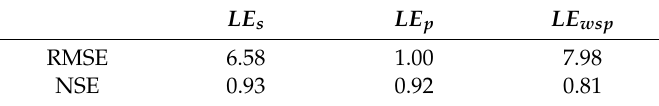
Figure 3. The linear relationship between the predicted and measured values of latent fluxes under WSPI: ( a ) LE s ; ( b ) LE p ; ( c ) LE wsp . Table 3. Results of root mean square error (RMSE) and Nash-Sutcliffe efficiency (NSE) when simulating (cid:0) (cid:1) LE s , LE p and LE wsp W · m − 2